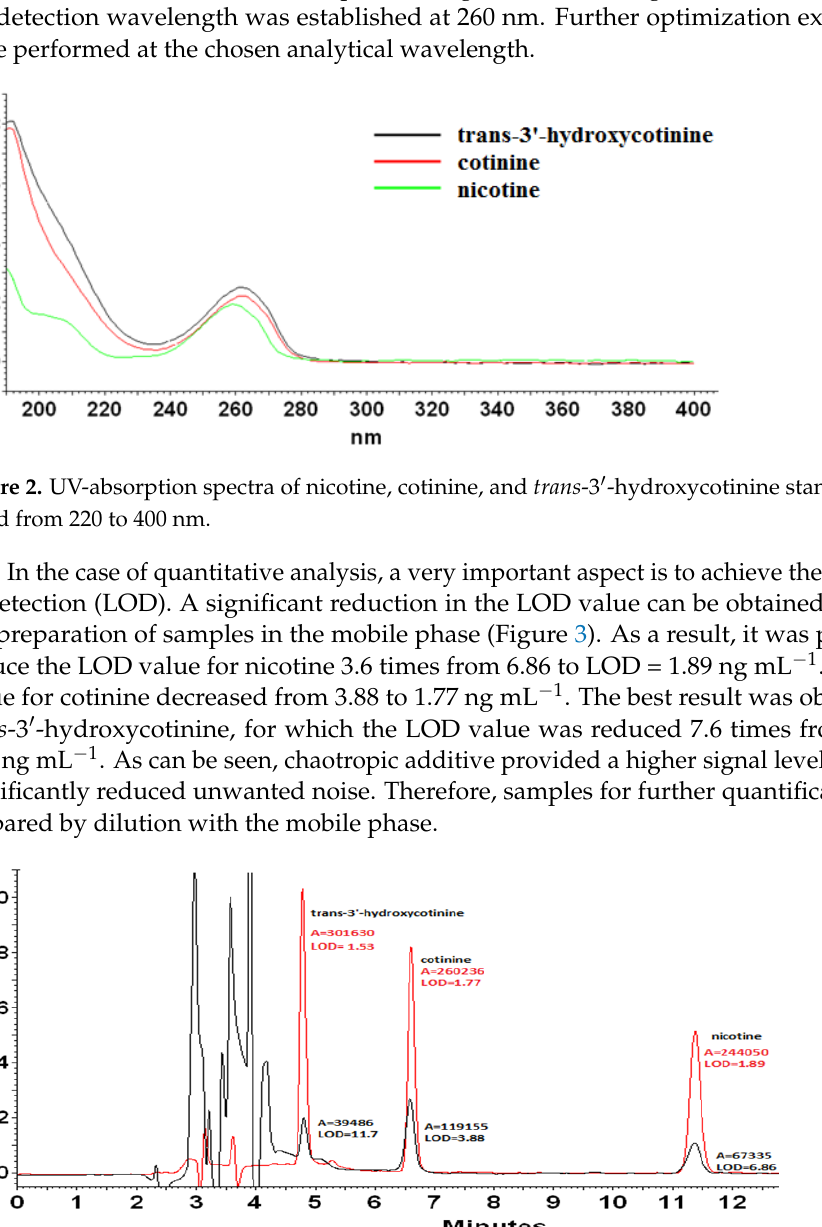
Figure 1. HPLC-DAD chromatogram obtained for solution of standards: trans -3 ′ -hydroxycotinine (tr = 4.63 min), cotinine (tr = 6.16 min), nicotine (tr = 11.01 min) at the concentration level of 500 ng L − 1 . The analysis was performed using an Agilent 5 HC-C18(2) (250 × 4.6 mm I.D.) column. The mobile phase was acetonitrile (10%, v / v ), 20 mM phosphate buffer pH = 2.7 containing 30 mM